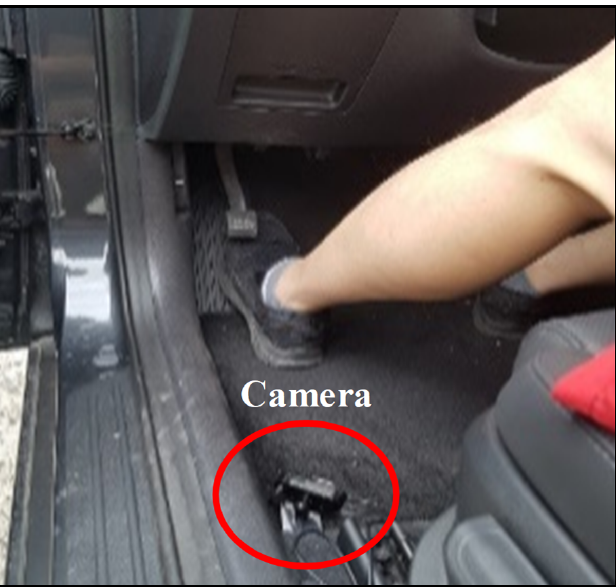
Figure 4 . Illustration of the camera position . Figure 4. Illustration of the camera